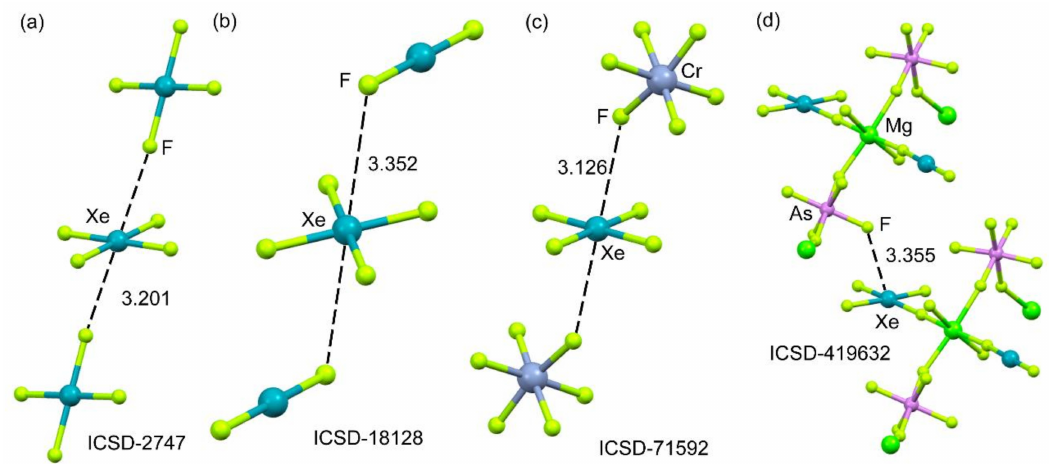
Figure 17. Partial views of the X-ray structures corresponding to ICSD reference codes ICSD-2747 ( a ), ICSD-18128 ( b ), ICSD-71592 ( c ), and ICSD-419632 ( d ), corresponding to xenon tetrafluoride, xenon difluoride-xenon tetrafluoride, (CrF 6 ) 4 (XeF 4 ) 5 and [Mg(XeF 2 )(XeF 4 )](AsF 6 ) 2 , respectively. Distances in